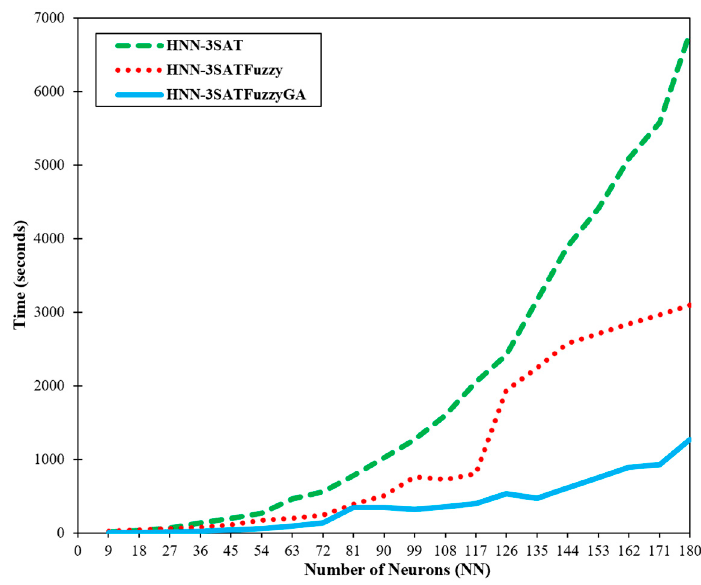
Figure 9. Processing